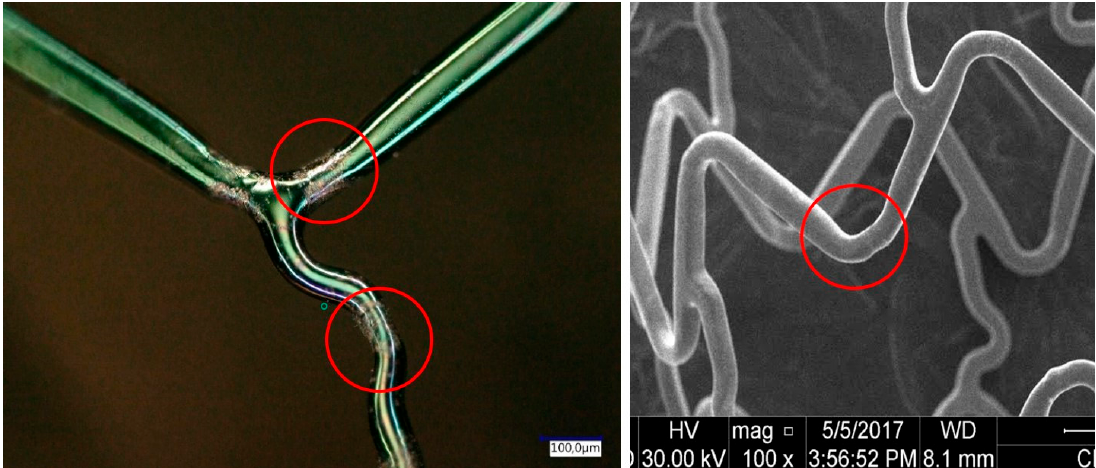
Figure 3. Thinned area in the strut formed after stent expansion.